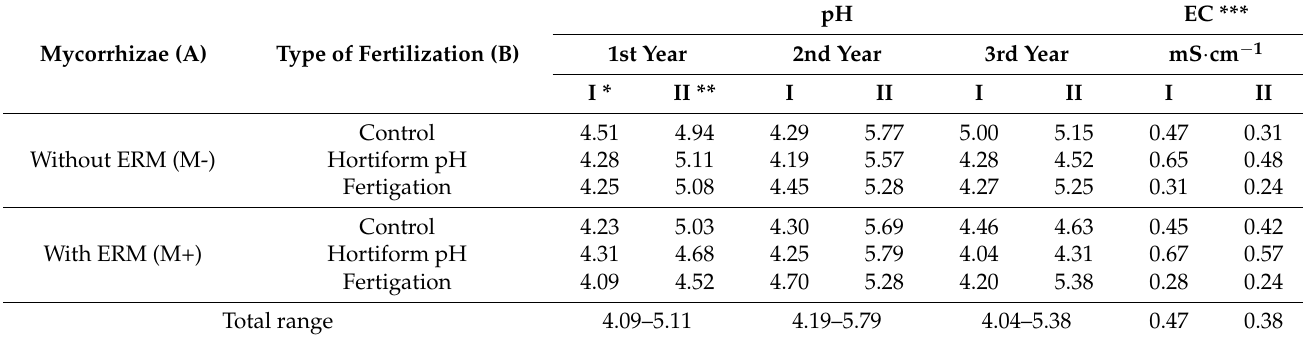
Table 2. Effect of fertilization and mycorrhization on reaction pH (H2O) and salinity EC (mS · cm − 1 ) in azalea substrate.